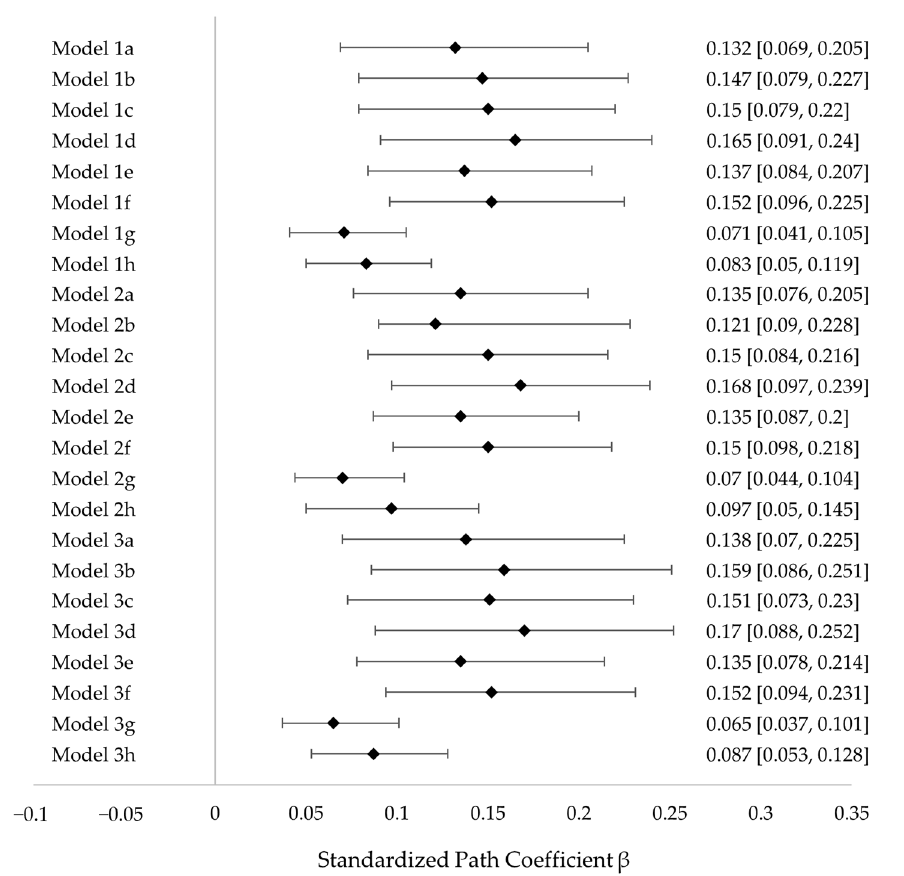
Figure 3. Coefficient plot displaying standardized coefficients of indirect paths from all calculated models. Indirect effect shown: social anxiety → FPE → acceptance → suppression.